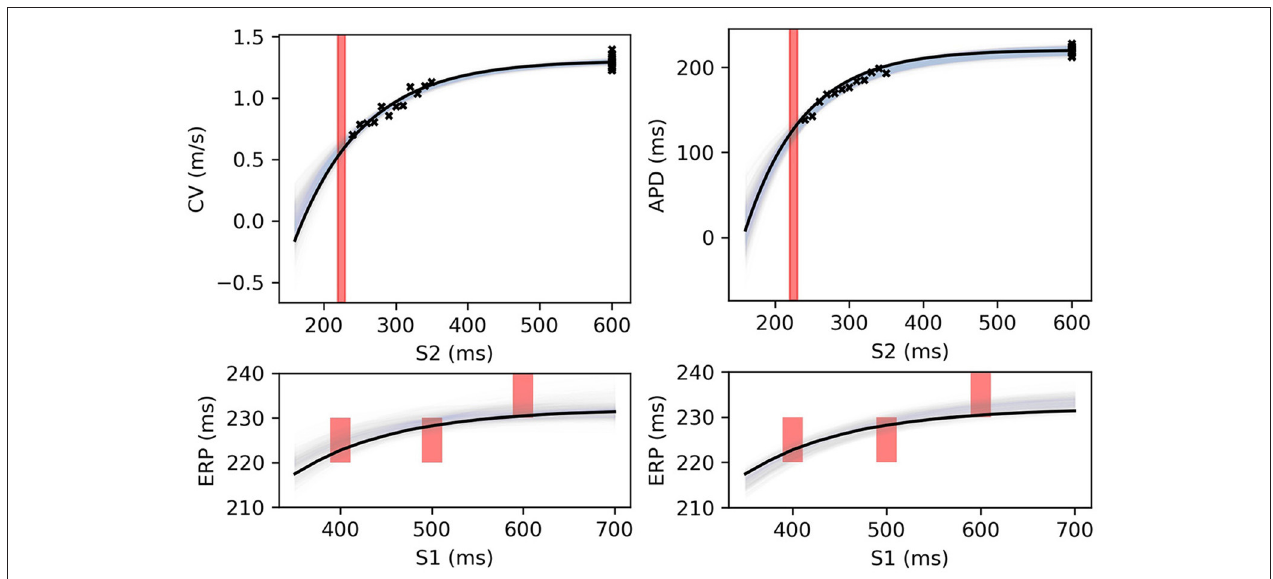
FIGURE 9 | RCE predictions, shown as lightly shaded regions representing 95% confidence intervals, for 100 parameter samples from the posterior distribution given the same measurements shown in Figure 8 [black crosses are noisy S2 restitution data, red bars are observed ERP intervals, (left) MCMC with CV(S2) and ERP(S1) data, (right) MCMC with APD(S2) and ERP(S1) data].